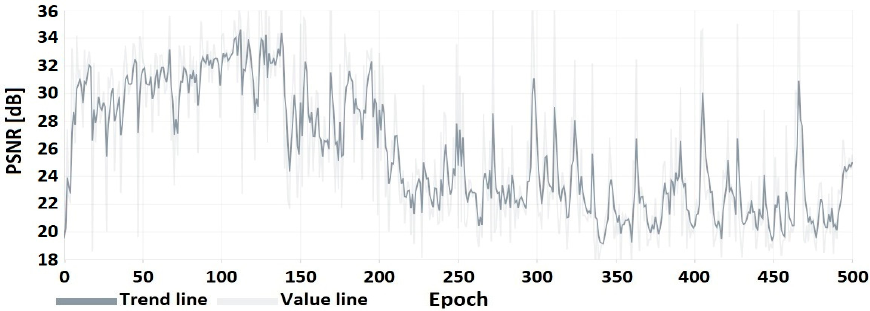
Figure 9. PSNR of the hidden image (watermark in the form of image) relative to the recovered image.